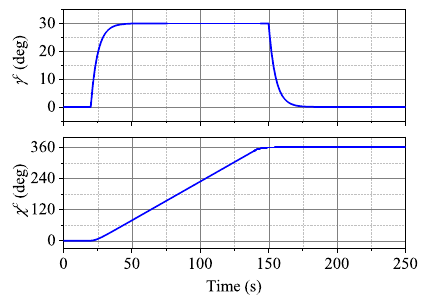
Figure 3. Rudder deflections in simulation